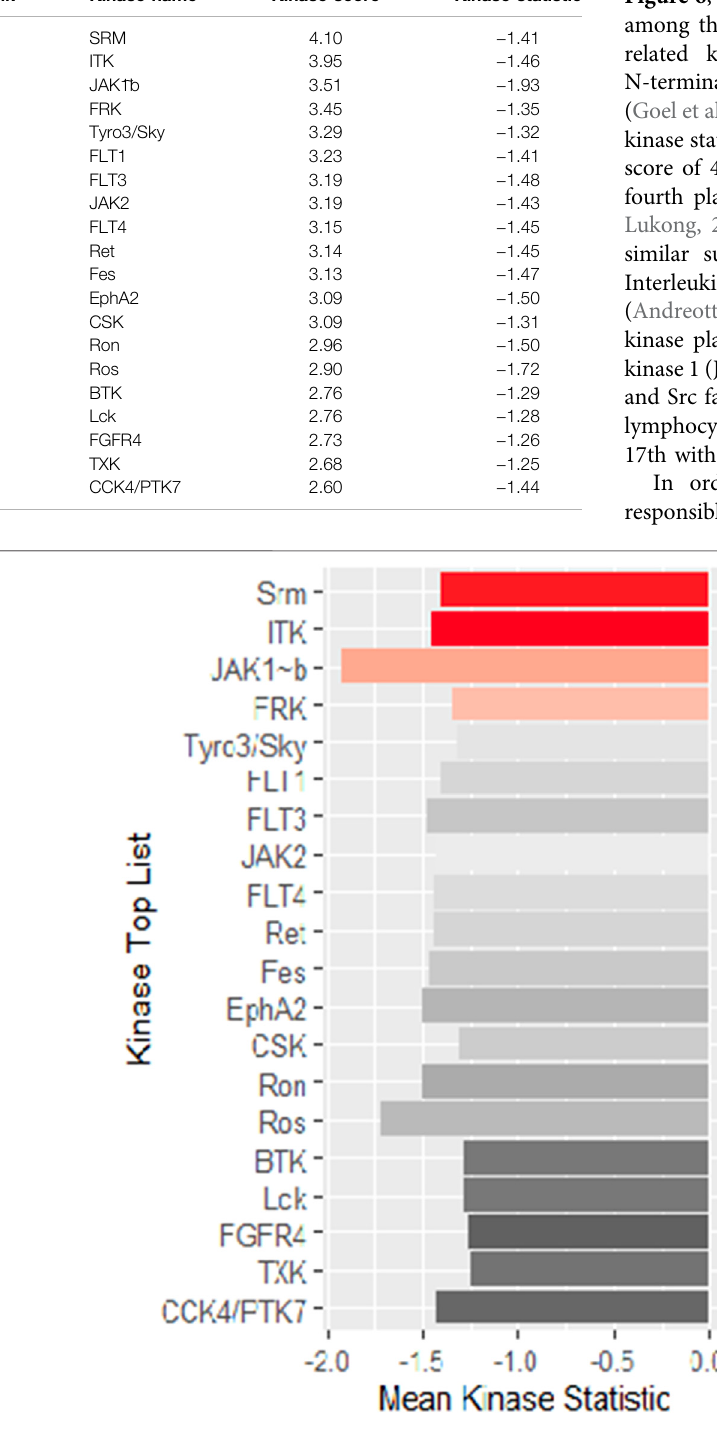
FIGURE 6 | Mean kinase statistics (represented by bar length) and mean speci fi city score (represented by color scheme) for the top 20 affected PTKs after treatment of HL60 cells with KIM-161 at 0.1 µM.